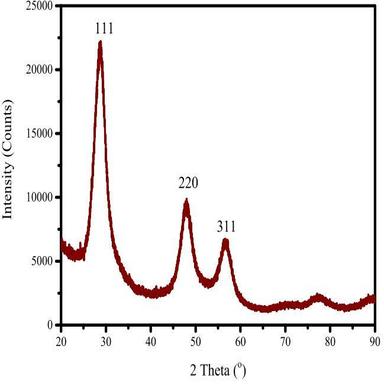
A powder XRD pattern of ZnS QD.